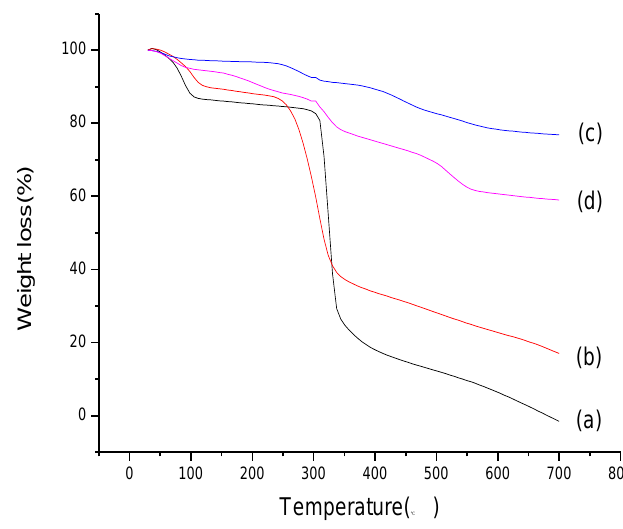
Figure 3. TG curves of β-CD (a), 6-EA-β-CD (b), Cl-Si (c) and 6-EA-β-CD-Si (d).